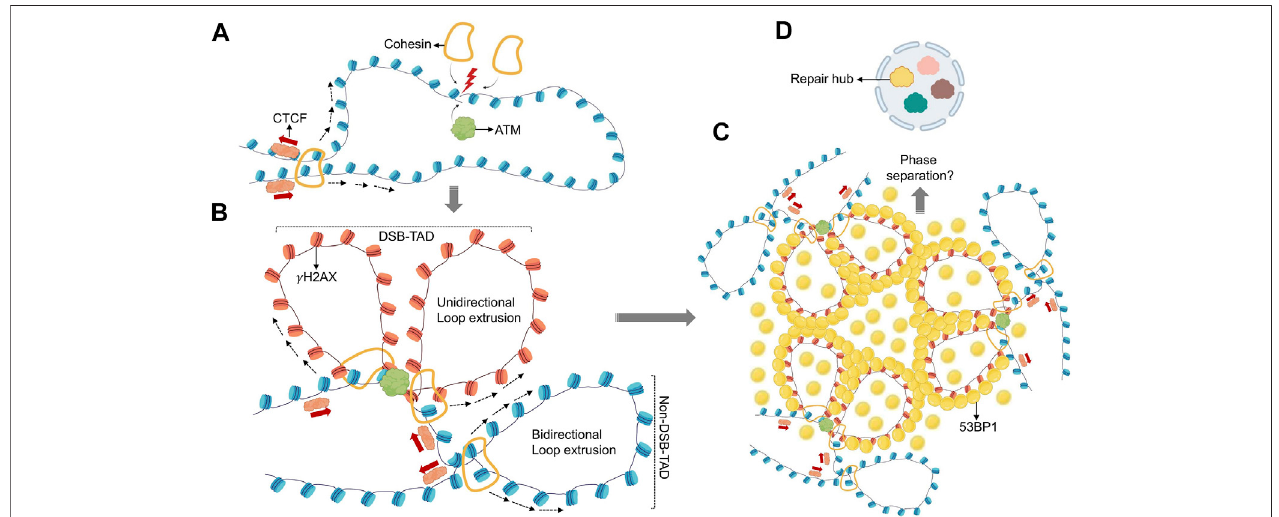
FIGURE 1 | Role of loop extrusion in establishing repair domains. (A) DSBs initiate recruitment of ATM kinase and the cohesin complex. (B) DSB-associated cohesin anchors initiate unidirectional loop extrusion at both DSB ends, towards TAD anchors. ATM phosphorylates H2AX while nucleosomes are extruded ( γ H2AX nucleosomes are shown in red). Loop extrusion stops when existing TAD boundaires are encountered. This process generates a TAD-overlapping γ H2AX domain. (C) γ H2AX domains recruit 53BP1 repair factors creating similar, TAD-overlapping 53BP1 pro fi les. (D) 53BP1 mediated phase separation at TAD-associated 53BP1 domains may promote higher-order assembly of multiple 53BP1-TADs, and possibly multiple DSBs, to create spatially segregated repair hubs (yellow). Distinct nuclear subcompartments are symbolized in different colors.